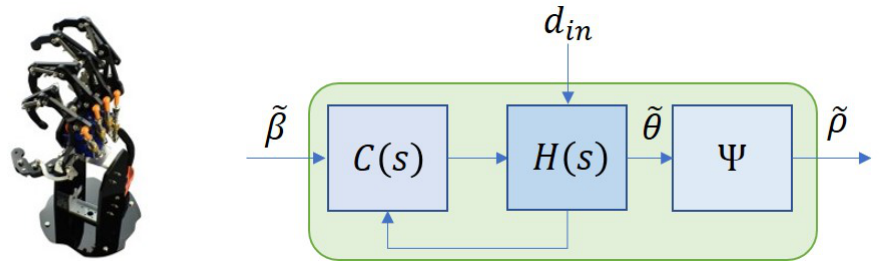
Figure 5. Bionic hand ( left ); Closed-loop control structure of the bionic hand ( right ).